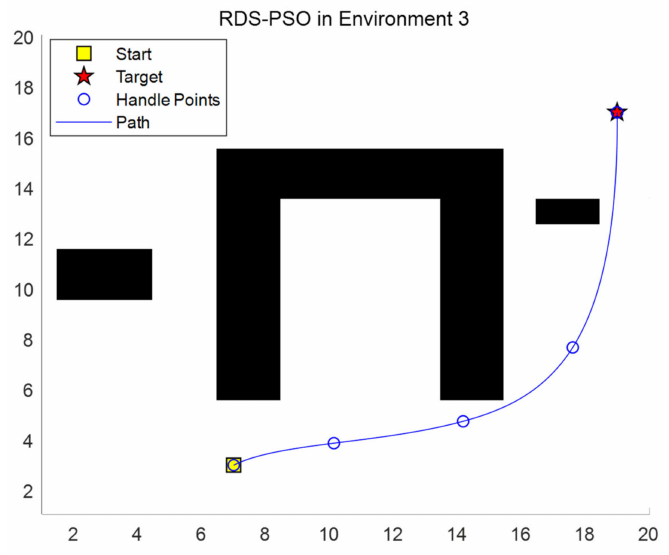
Figure 9. Path planning of RDS-PSO in map 3.